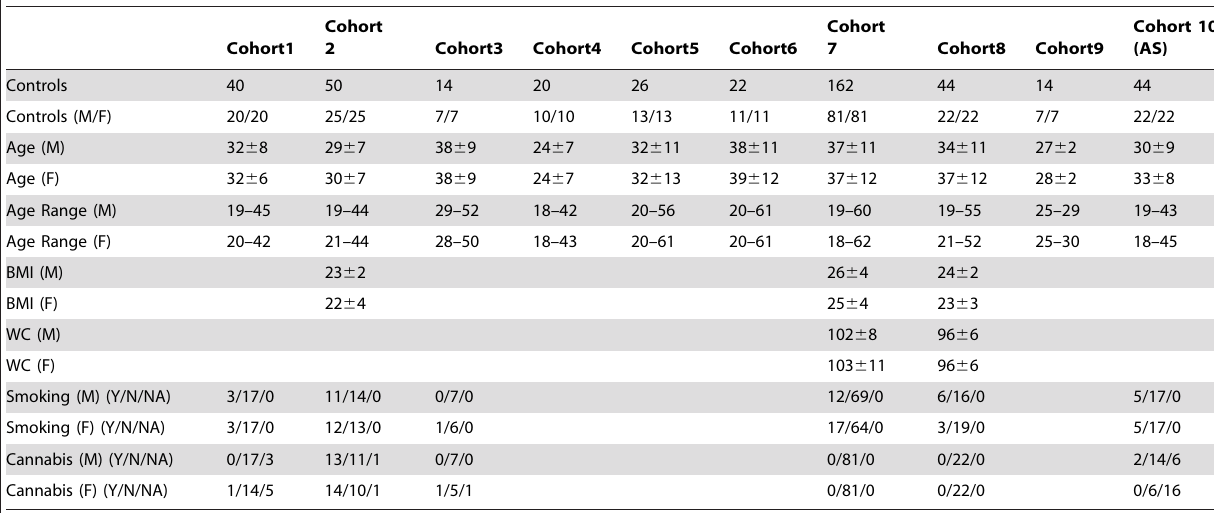
Table 1. Metadata for all